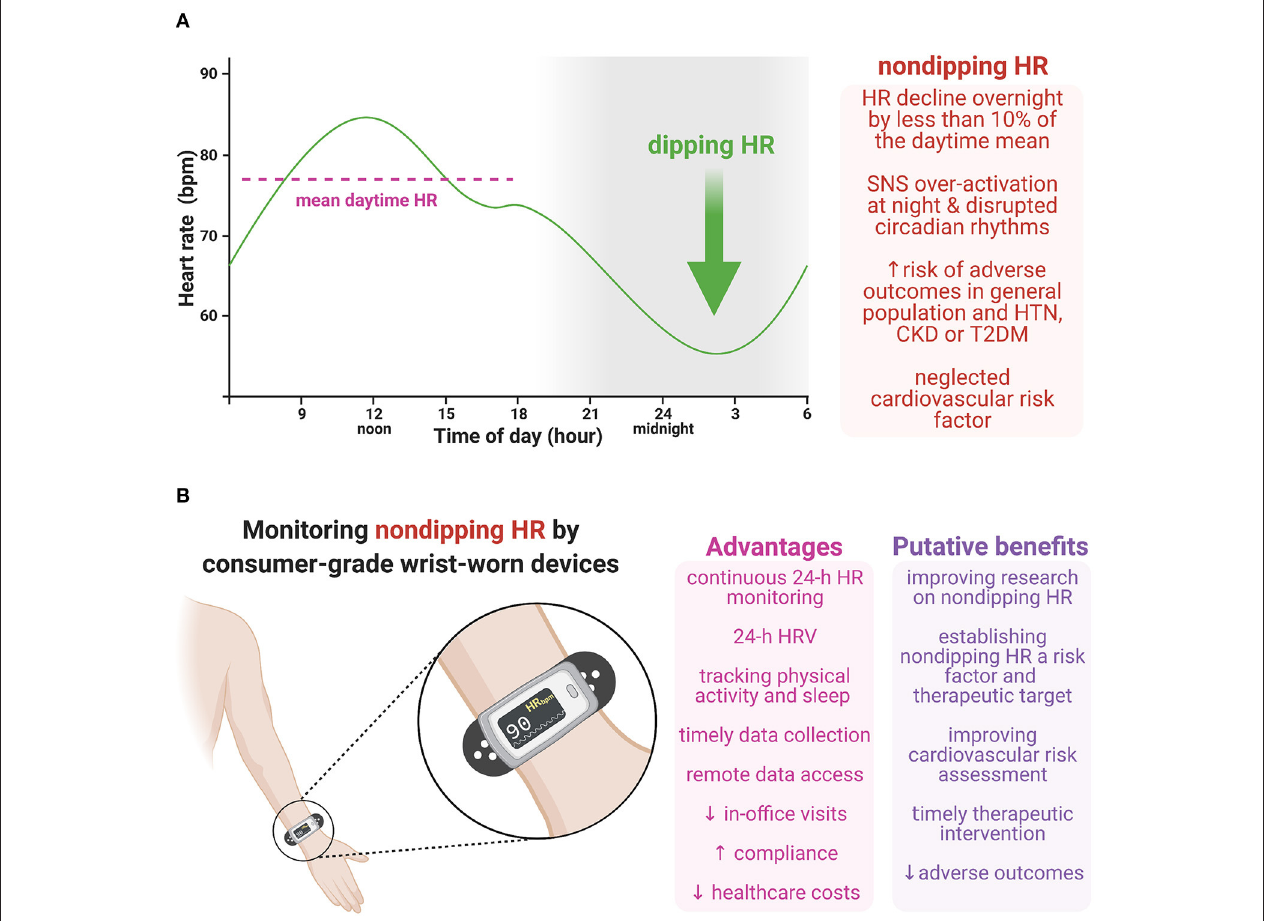
FIGURE 1 | (A) Non-dipping heart rate (HR), i.e., HR decline overnight by < 10% of the daytime mean, is coupled with an increased risk of adverse outcomes in the general population and various cardiovascular pathologies. Although sustained sympathetic over-activation at night is considered to be pivotal in the pathophysiology of non-dipping HR, other factors may also be involved, such as the disrupted endogenous circadian rhythmicity of the central clock in the suprachiasmatic nucleus, the cardiac clock in the sinoatrial node, or circulating neurohumoral factors, including catecholamines and glucocorticoids. (B) Consumer-grade wrist-worn devices provide continuous HR monitoring during a 24-hour (24-h) period (or even longer), with simultaneous physical activity and sleep tracking and determining HR variability (HRV). Moreover, these devices enable timely data collection with no subjective data reporting or secondary data entry, and remote access to data coming with increased patient compliance and reduced in-office visits and healthcare costs. Monitoring non-dipping HR with wearable devices could improve the pathophysiological understanding of this phenomenon, show its prognostic value in cardiovascular as well as other pathologies and help to develop a therapeutic approach targeting non-dipping HR. Moreover, considering 24-h HRV together with other metrics simultaneously measured by wrist-worn devices (e.g., 24-h HR, non-dipping HR or activity/sleep data) might further improve cardiovascular risk assessment. Thus, this cost-effective approach could potentially improve cardiovascular risk assessment, reduce adverse outcomes by timely therapeutic intervention, and curb long-term healthcare expenditures. CKD, chronic kidney disease; HR, heart rate; HRV, heart rate variability; HTN, hypertension; SNS, sympathetic nervous system; T2DM, type 2 diabetes mellitus. Created with